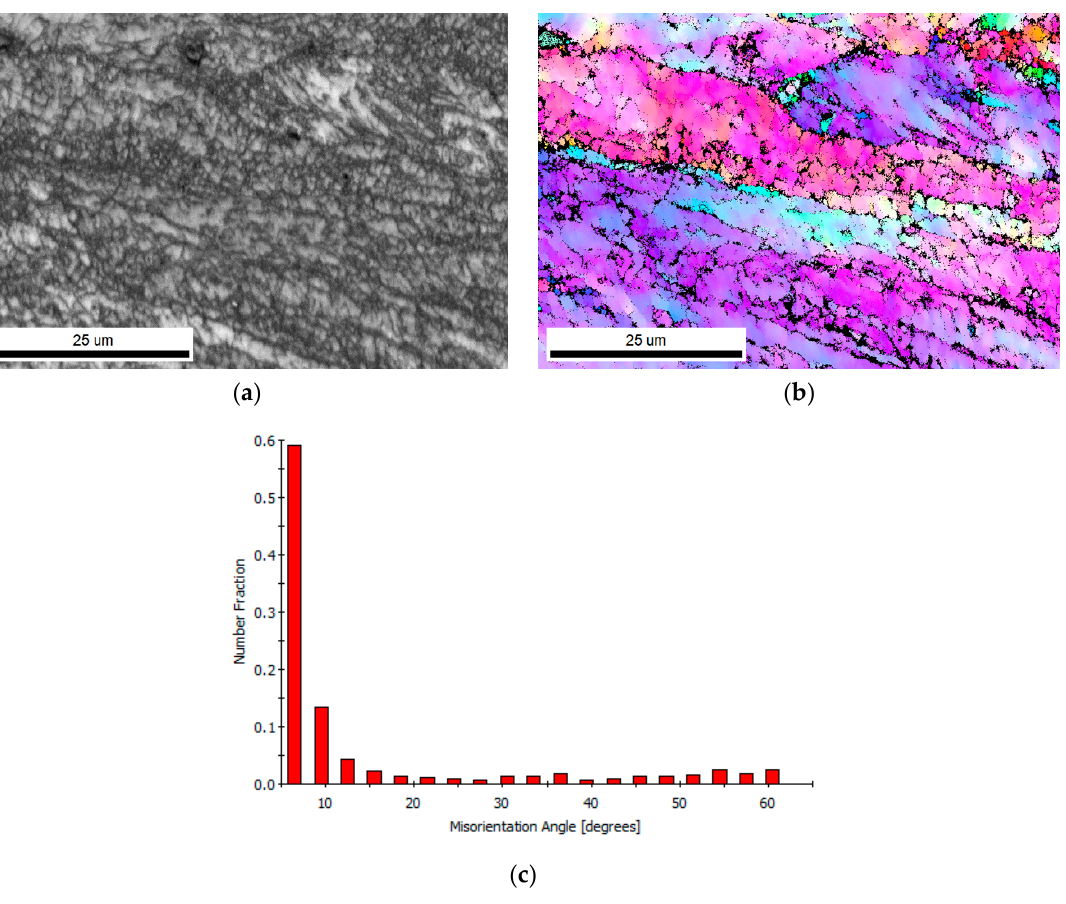
Figure 5. EBSD analysis of the as-received AA5083 after four (D) sc-ECAE passes: ( a ) image quality map (step size is 70 nm); ( b ) color-coded orientation map; and ( c ) misorientation angle histogram (5° is set as the minimum). Lamellae in ( a , b ) are oriented along the extrusion direction.